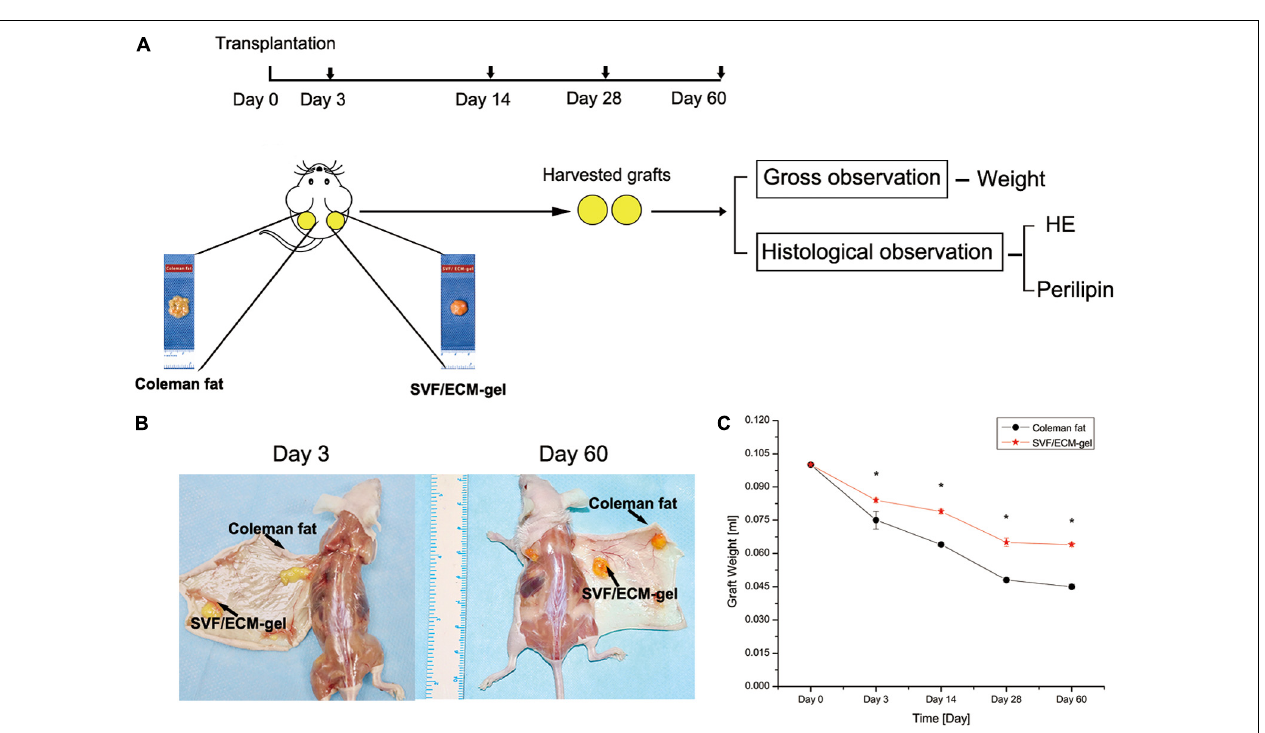
FIGURE 2 | Comparison of the general characteristics and retention rates of fat grafts. (A) Experimental design. (B) General observation of the two types of fat grafts at 3 and 60 days after transplantation. (C) Changes in fat retention rate. * P <